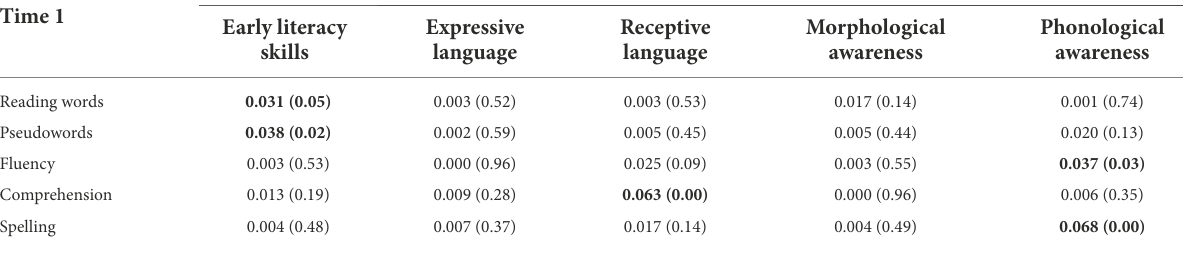
TABLE 7 Hierarchical multiple regression analysis results (Time 2: beginning of 1st